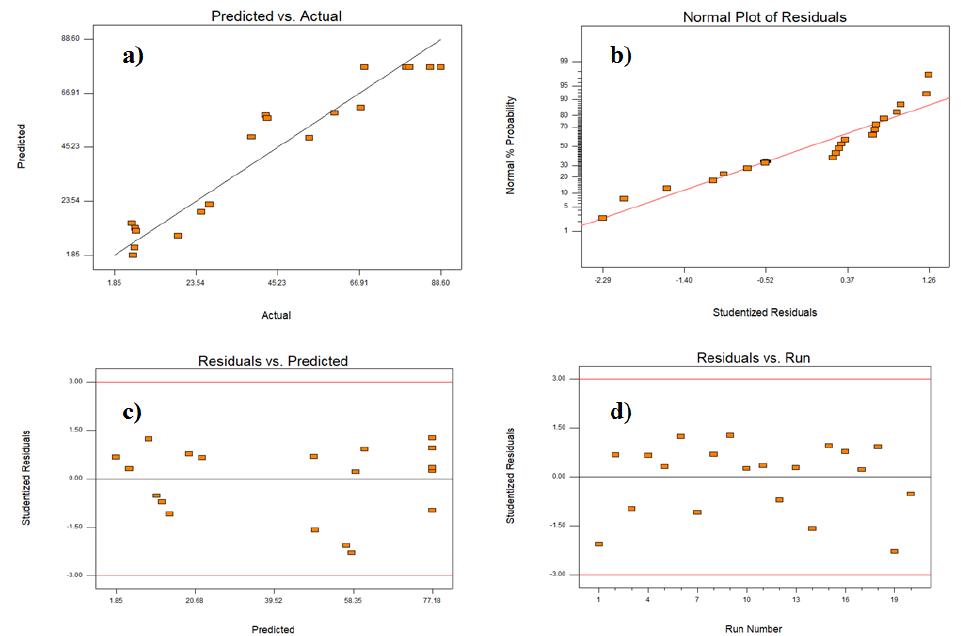
Fig. 9. Diagnostic plot of (a) predicted vs actual value, (b) normal plot of residuals, (c) residuals vs predicted and (d) residuals vs run.